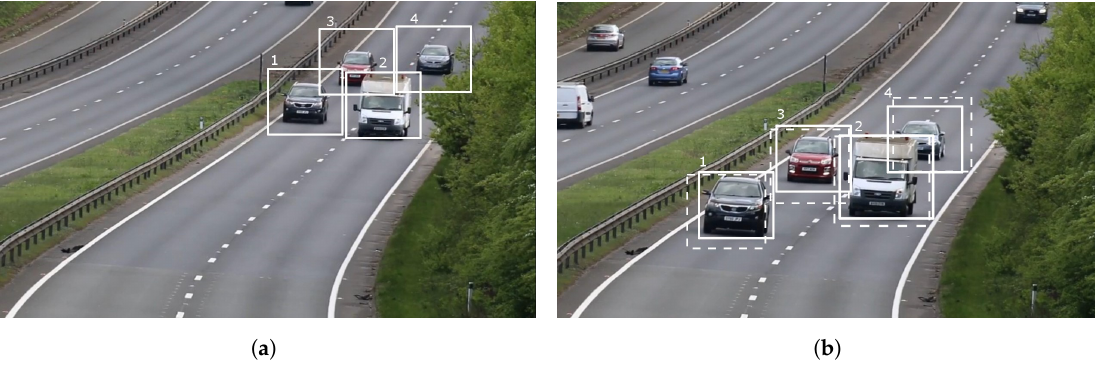
Figure 9. Tracking vehicles with predictions at low FPS. Each of the four objects gets detected in the first frame ( a ). The tracking algorithm tries to match objects based on a minimum distance to the predictions (dashed boxes) in the next frame ( b ). An association can be performed without the need for analysing the visual appearance of objects which can change greatly on low FPS. Source: